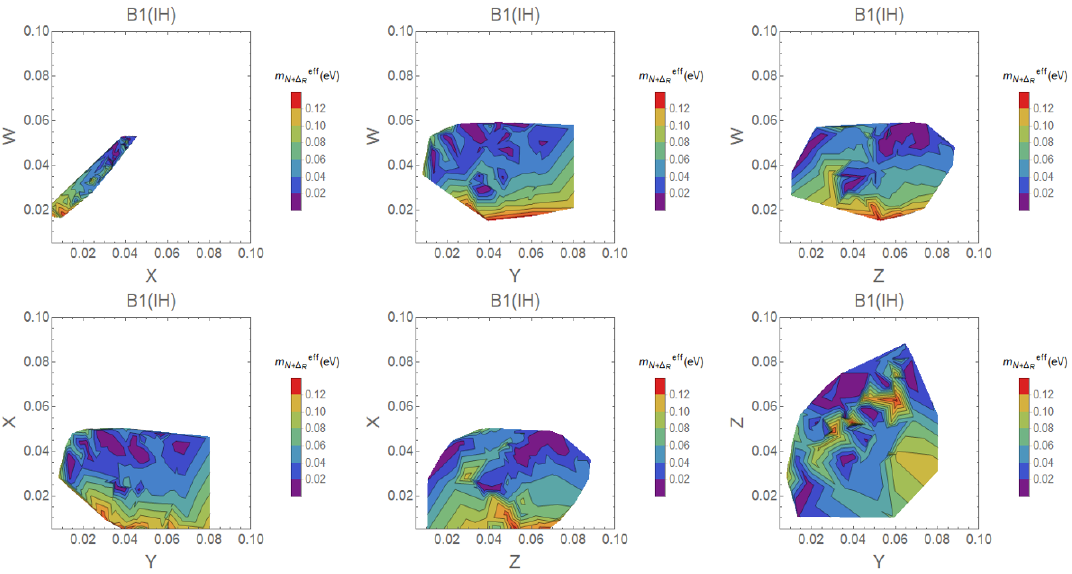
JHEP02(2019)129